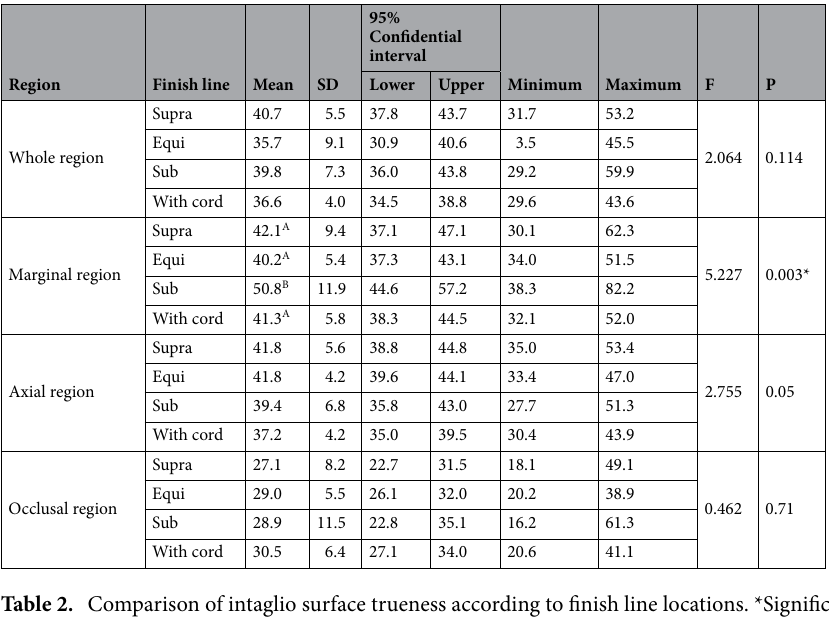
Table 2. Comparison of intaglio surface trueness according to finish line locations. *Significance determined by one-way ANOVA, P < 0.05. Different letters indicate significant differences among finish line locations by Tukey HSD test, P < 0.05.